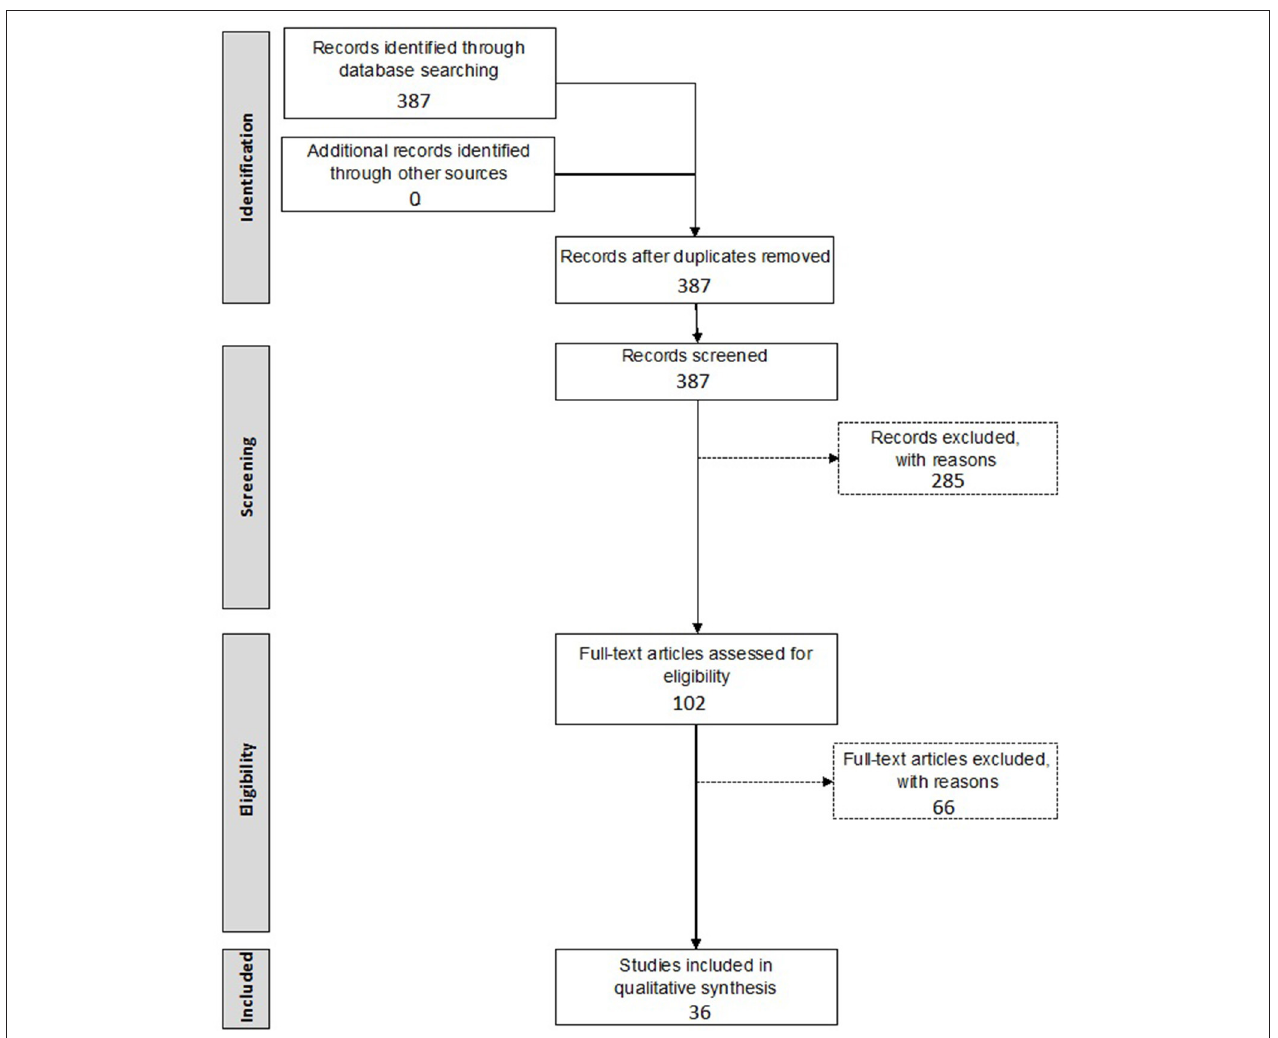
FIGURE 1 | Flow chart of systematic review of gene therapy in the inner